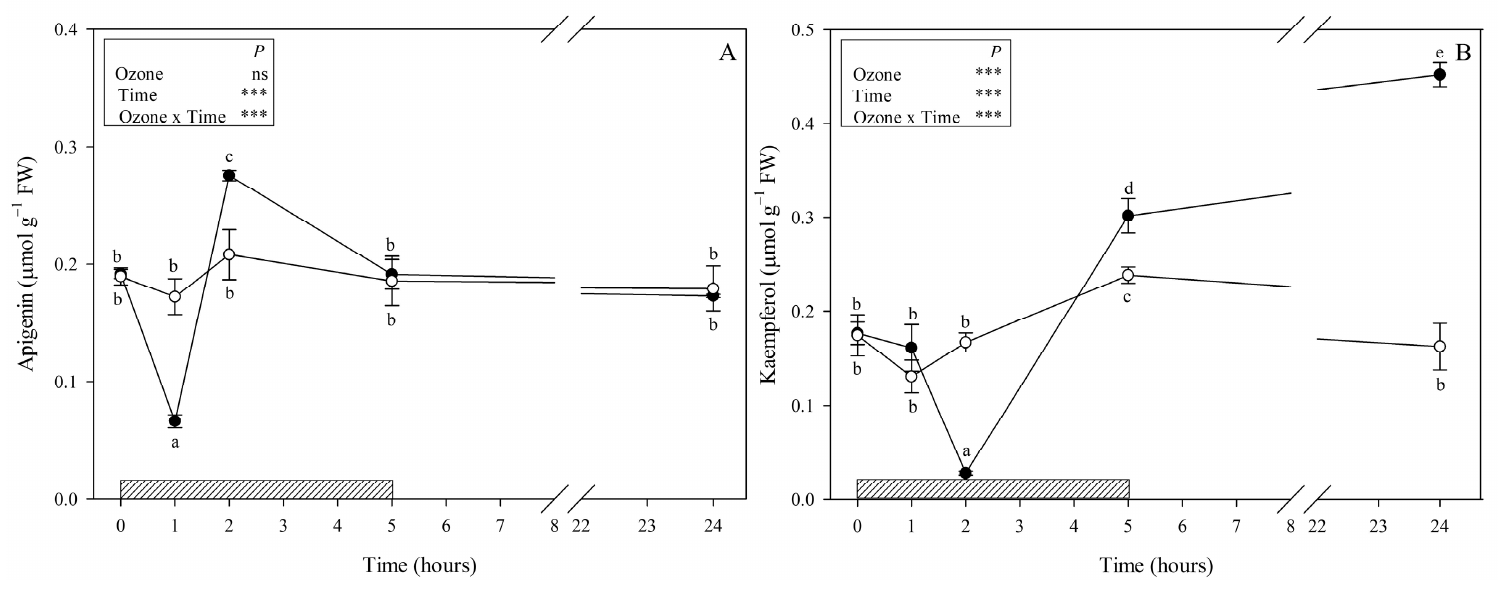
Figure 3. Content of flavonoids (apigenin ( A ), kaempferol ( B )) ( µ mol g − 1 FW) in leaves of Salvia o ffi cinalis exposed to ozone (120 ppb, 5 h; closed circle) or maintained under filtered air (controls; open circle). Measurements were carried out at 0, 1, 2, 5, and 24 h from the beginning of exposure. Data are shown as mean ± standard deviation ( n = 3). p -values show the results of a full factorial two-way ANOVA with O 3 and time as variability factors (*** p ≤ 0.001; ns: p > 0.05). For each compound ( A , B ), di ff erent lowercase letters (a–e) indicate significant di ff erences among means, according to the Tukey’s HSD post-hoc test ( p ≤ 0.05). FW = fresh